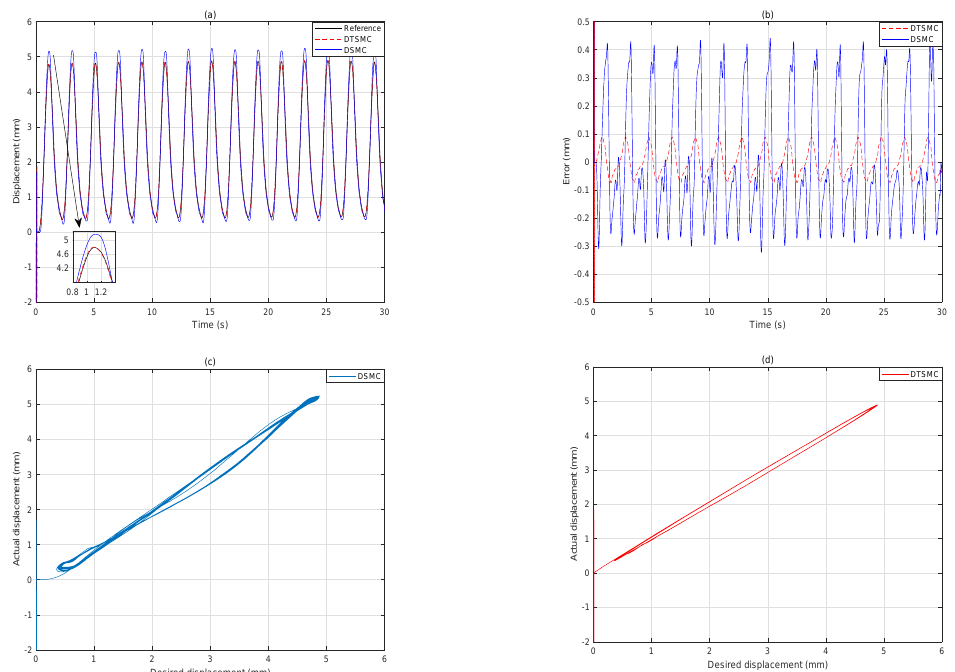
Figure 14. The tracking results under 0.5 Hz input signal. ( a ) Displacement output. ( b ) Tracking error. ( c ) Desired displacement versus actual displacement of the DSMC. ( d ) Desired displacement versus actual displacement of the